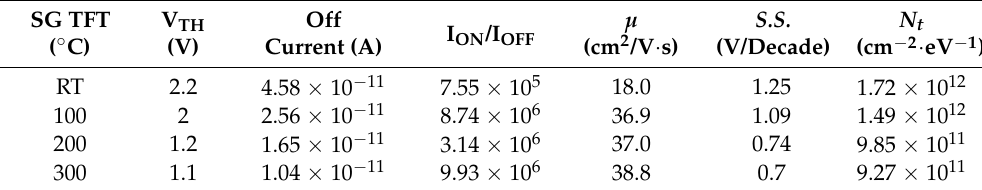
Table 1. Electrical characteristics of SG TFTs with a 33% O 2 plasma–treated IGZO channel layer and annealed at temperatures from RT to 300 ◦